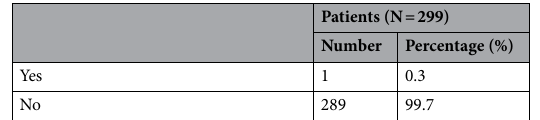
Table 1. Patient demographic characteristics and echocardiographic findings AR aortic valve regurgitation; TR tricuspid valve regurgitation; MR mitral valve regurgitation; PR pulmonary valve